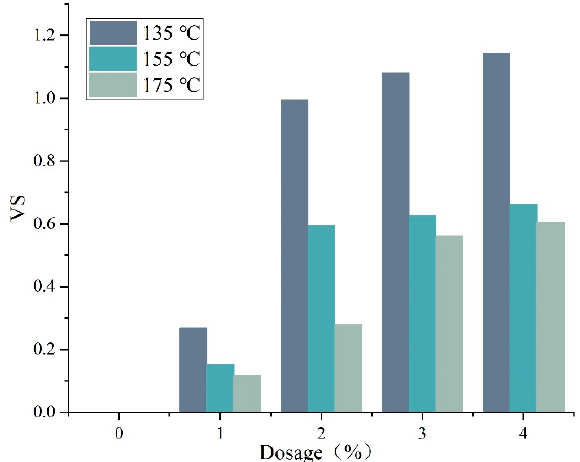
Figure 7. DM-modified asphalt VS index comparison results.